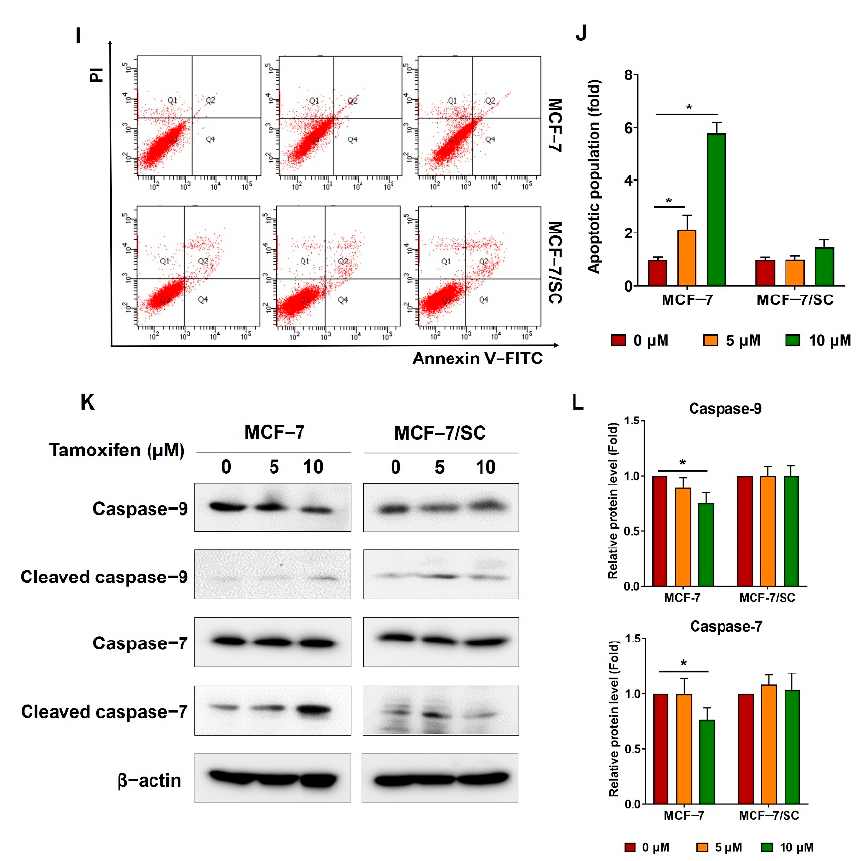
Figure 2. MCF − 7/SC cells displayed resistance to tamoxifen. Viability of MCF − 7 and MCF − 7/SC cells was determined after tamoxifen treatment for 24 h ( A ) and 48 h ( B ). The effect of tamoxifen on ( C , D ) colony formation, ( E , F ) migration, and ( G , H ) invasive capacity was compared between MCF − 7 and MCF − 7/SC cells. ( I , J ) The apoptotic population detected after tamoxifen treatment. ( K , L ) Western blot analysis for apoptosis markers after tamoxifen exposure. β− actin was used as a loading control. The asterisk (*) indicates p < 0.05 vs. the control. Data were representative of three biologically independent experiments and values were shown in mean ± SD.